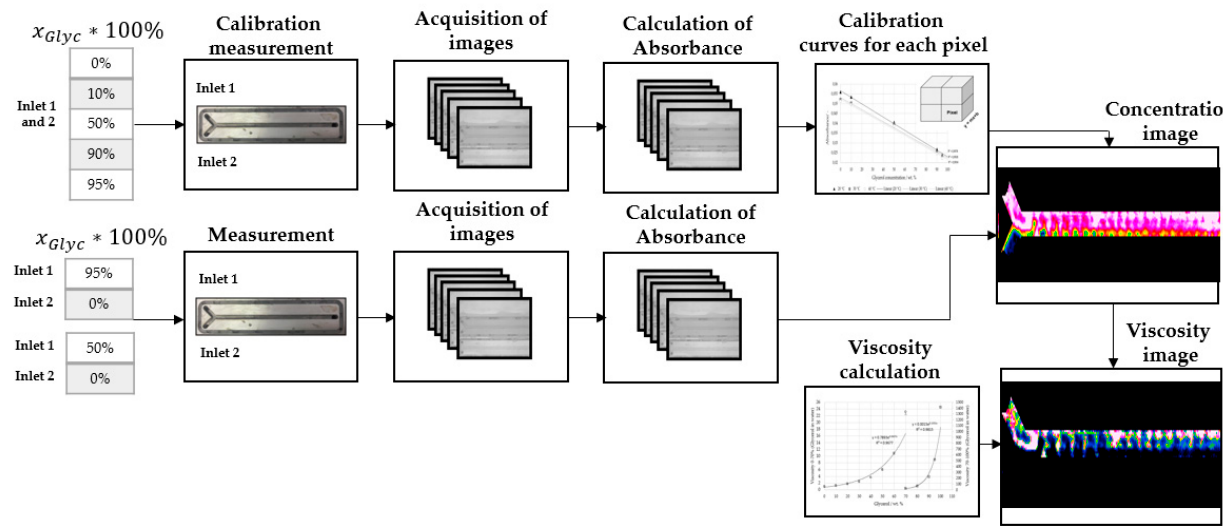
Figure 7. Schematic experimental workflow for the calibration and evaluation of the near-infrared measurement results.